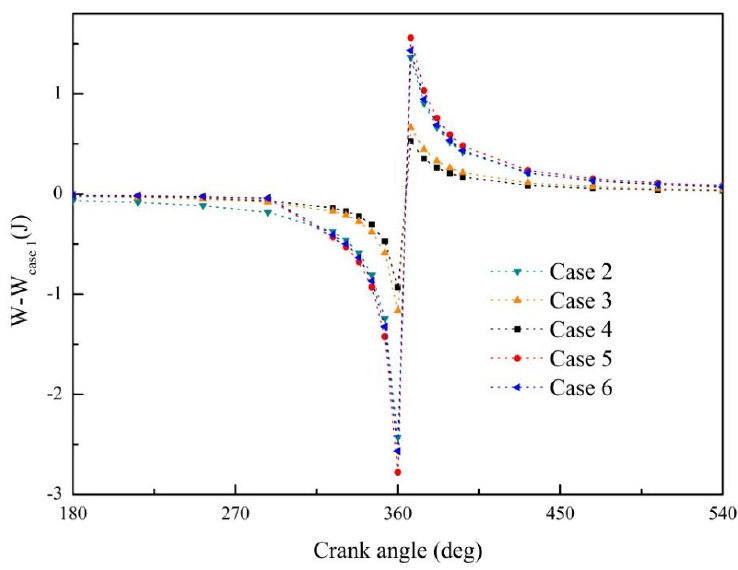
Figure 14. Work difference under different coolant conditions.